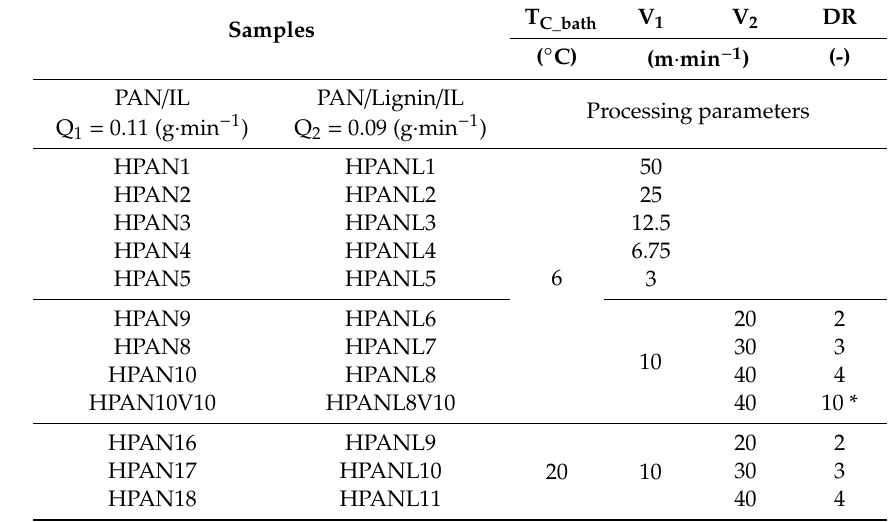
Table 2. Conducted spinning trails to evaluate the impact of di ff erent processing parameters, that is, the temperature of the coagulation bath (T C_bath ), the take-up speed of the first and the second godets, as well as the o ff -line drawing on the structure and mechanical properties of the regenerated PAN and PAN / lignin fibers. All spinning trails were conducted at a constant rotational speed of the spinning pump @ 0.5 rpm. *) Post-drawn (2.5 times) in solid-state at 170 ◦ C under air. DR, draw ratio; HPAN,